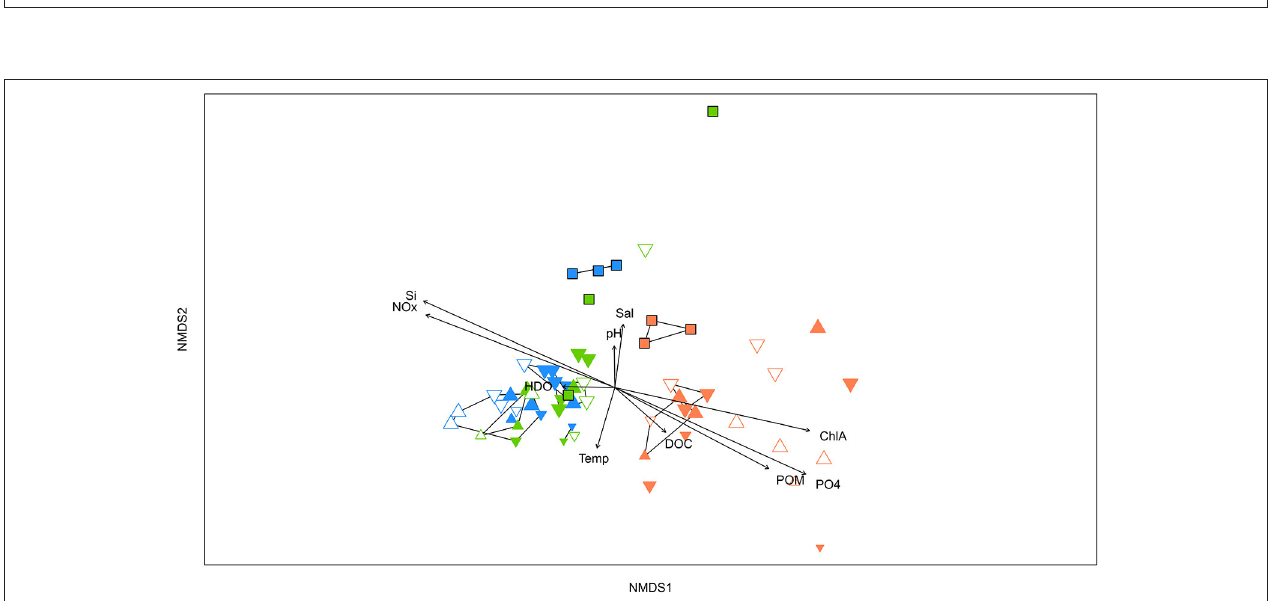
FIGURE 5 | Taxonomic composition at class-level of the bacterial communities on natural substrate. Shown are bacterial communities from three transects (roman numbers) at each of the three sites: inshore (LL), near-shore (BL), and mid-shelf (BD).